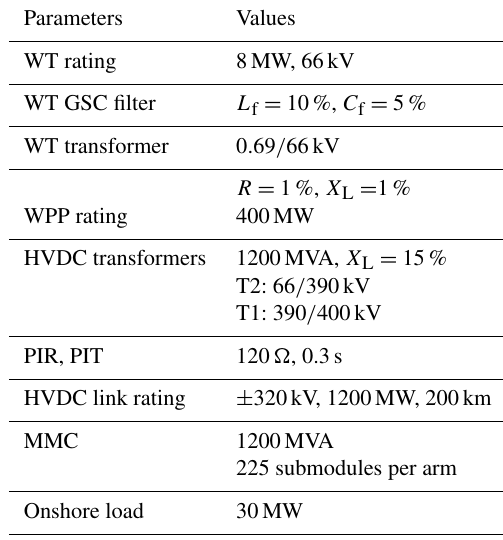
Table A1. Main circuit parameters of the model (T2 – offshore, T1 – onshore, X L – leakage reactance).